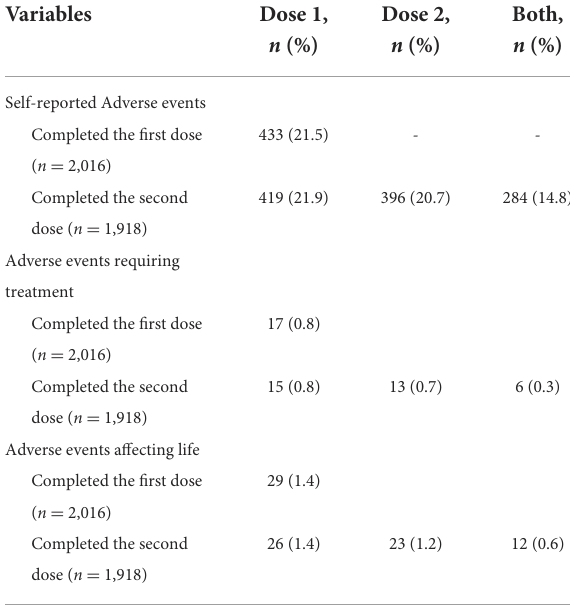
TABLE 3 Factors associated with COVID-19 vaccine acceptance expressed with odds ratio, in multivariate binary logistic regression.